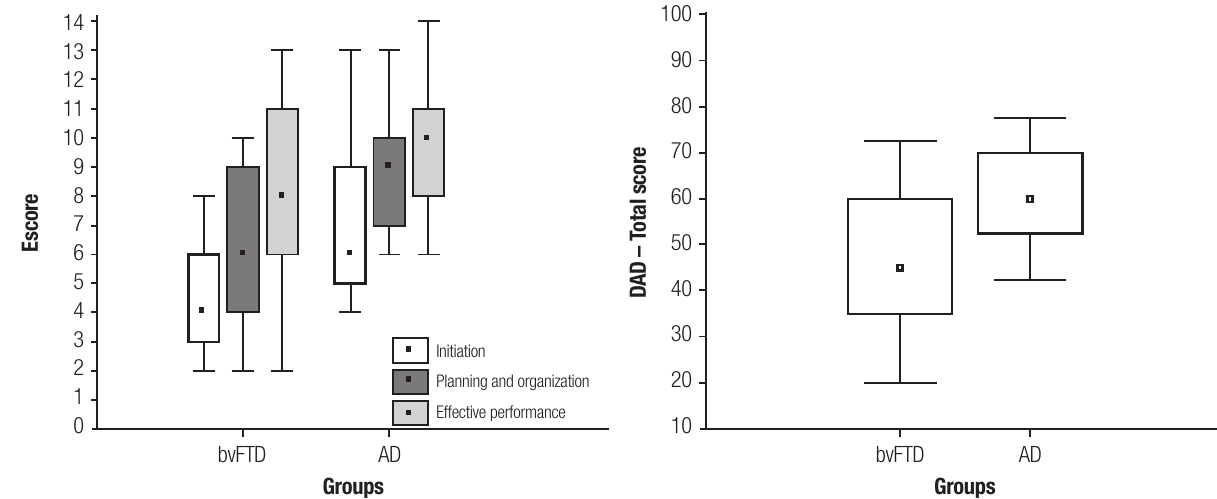
Figure 1. Initiation, planning and organization, effective performance, total score, disability assessment for dementia